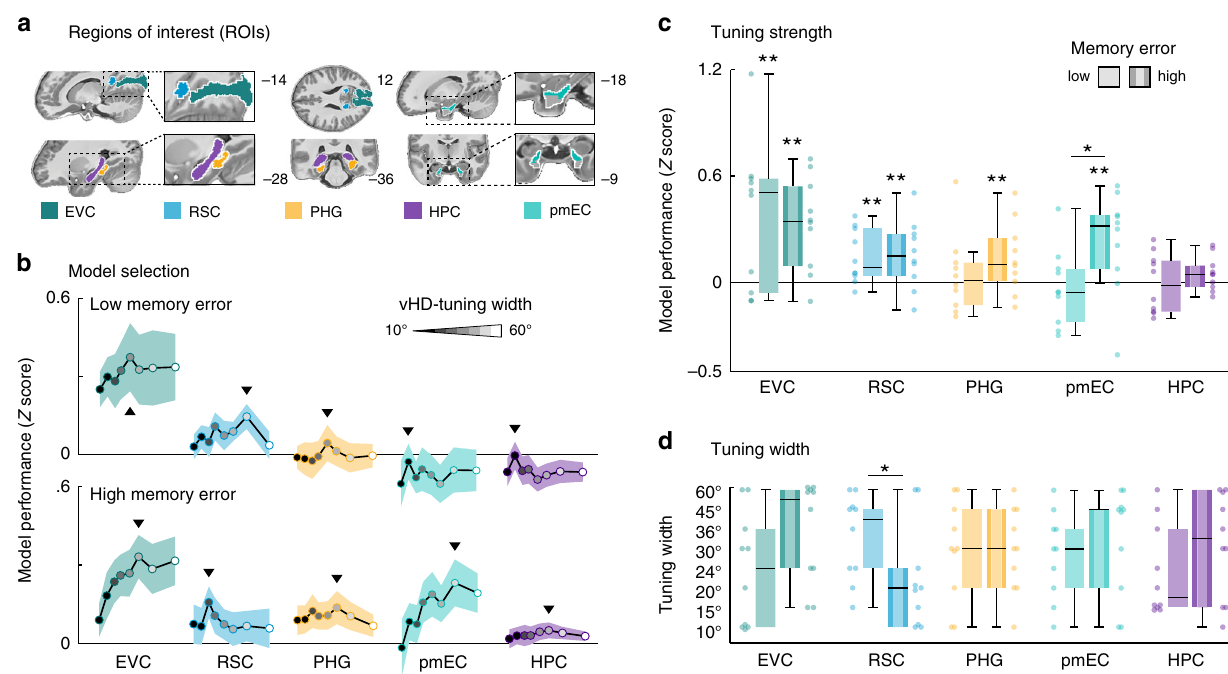
Fig. 5 Region-of-interest (ROI) analysis. a Human scene-processing and navigation regions tested in this study: early visual cortex (EVC), retrosplenial cortex (RSC), parahippocampal gyrus (PHG), posteromedial entorhinal cortex (pmEC), and the hippocampus (HPC). b Model selection: we plot the model performance ( Z score) on ROI level for all basis sets. The black line and the shaded area represent the mean and SEM across participants. Each dot represents the group-average model performance for one basis set, with darker colors representing narrow kernels and lighter colors representing wider kernels. The following kernel widths were tested: 10°, 15°, 20°, 24°, 30°, 36°, 45°, and 60°. The black triangles mark the basis set that leads to the optimal model performance. c Optimal model performance for the two (high- and low-memory-error) participant groups. We plot single-participant data and group-level whisker – boxplots (center, median; box, 25th to 75th percentiles; whiskers, 1.5× interquartile range, n = 2 × 10 participants). We observed directional tuning in EVC and RSC in both groups. In PHG and pmEC, this tuning depended on spatial memory performance. d Optimal tuning width. Similar to b , c we plot the tuning width that led to the optimal model performance selected on individual participant level. Participants with low-memory error had wider tuning than the ones with high-memory error. Hence, unlike tuning strength, the tuning width in RSC re fl ected spatial memory performance. One- sided (within-group) and two-sided (across-group) permutation-based t-test results were added: ** P < 0.05, FDR-corrected, * P < 0.05, uncorrected. Source data are provided as a Source Data fi